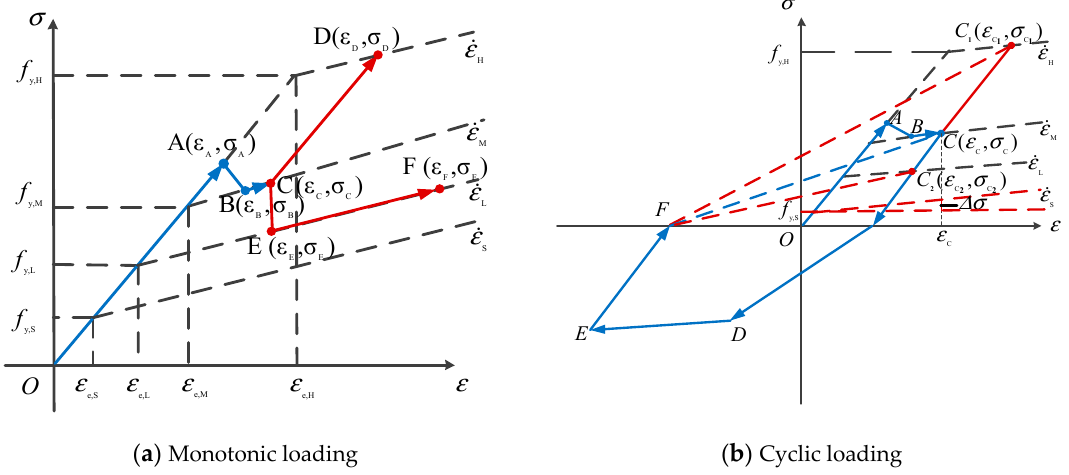
Figure 5. Considerations of the strain-rate effect in steel subroutine.